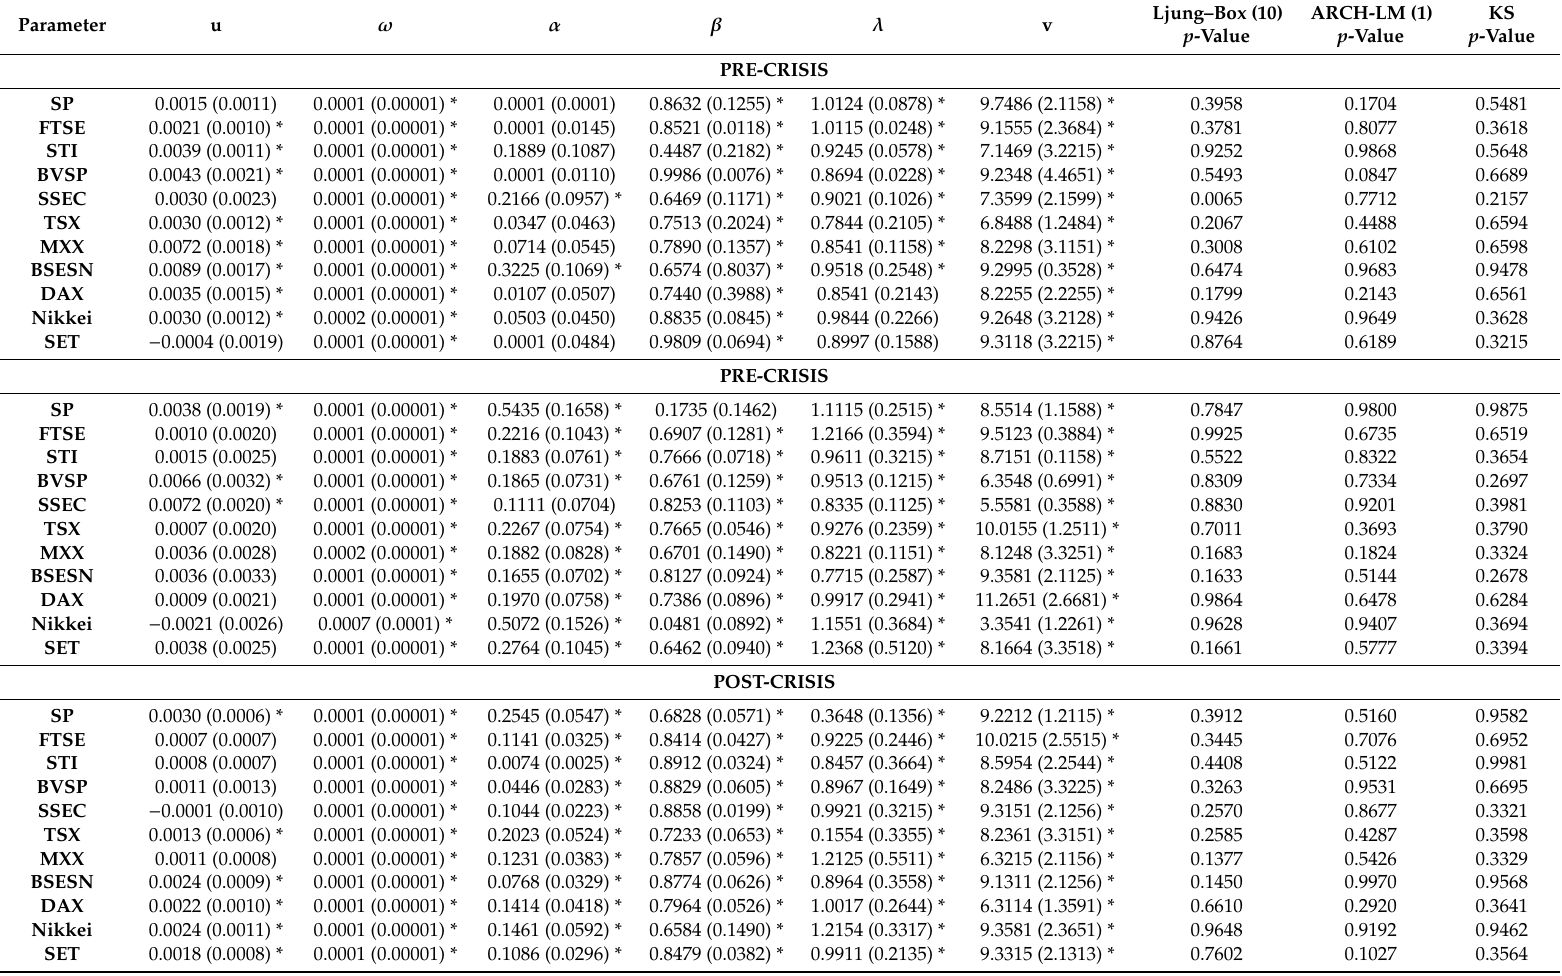
Table 3. Estimation results of the GARCH (1,1)-skew- t